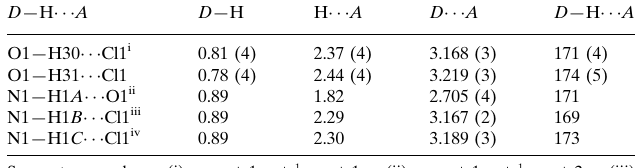
Hydrogen-bond geometry (A˚ , (cid:3)